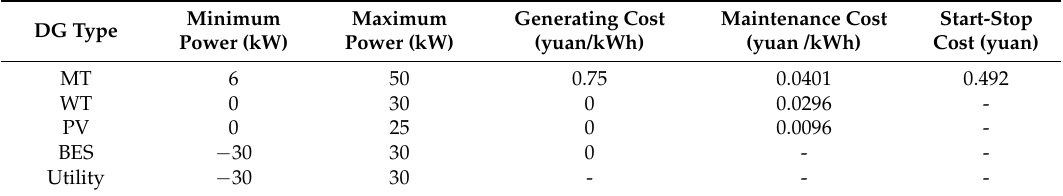
Table 1. The parameters of each DG.